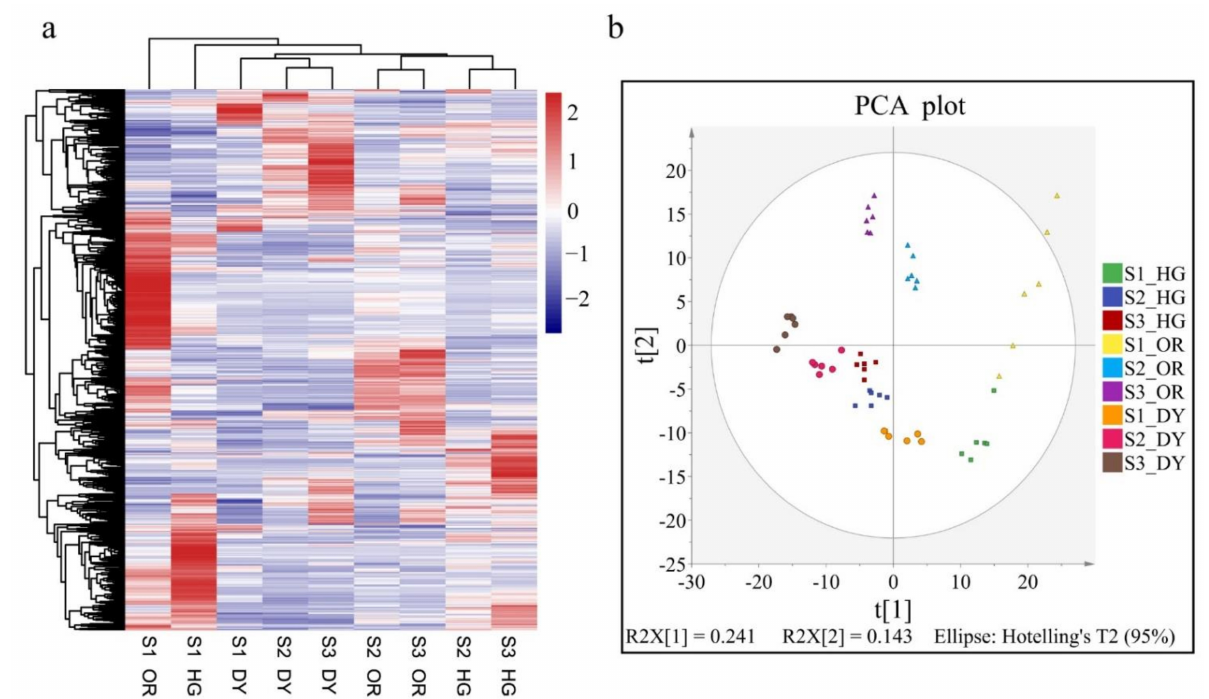
Figure 2. ( a ) Cluster heatmap based on different samples of different metabolites. Red represents up-regulation, and blue represents down-regulation. ( b ) Principal component analysis (PCA) of all